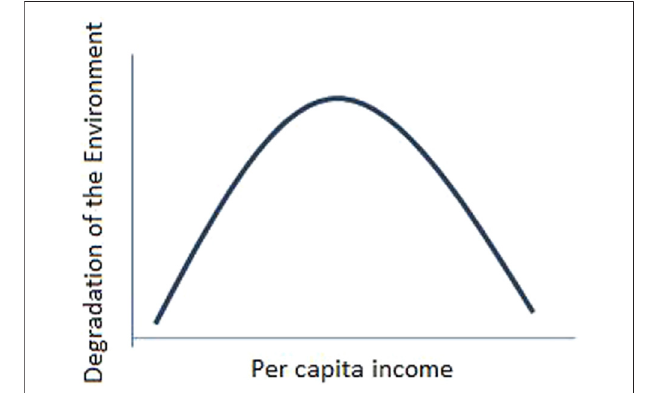
FIGURE 1 | Environmental kuznet